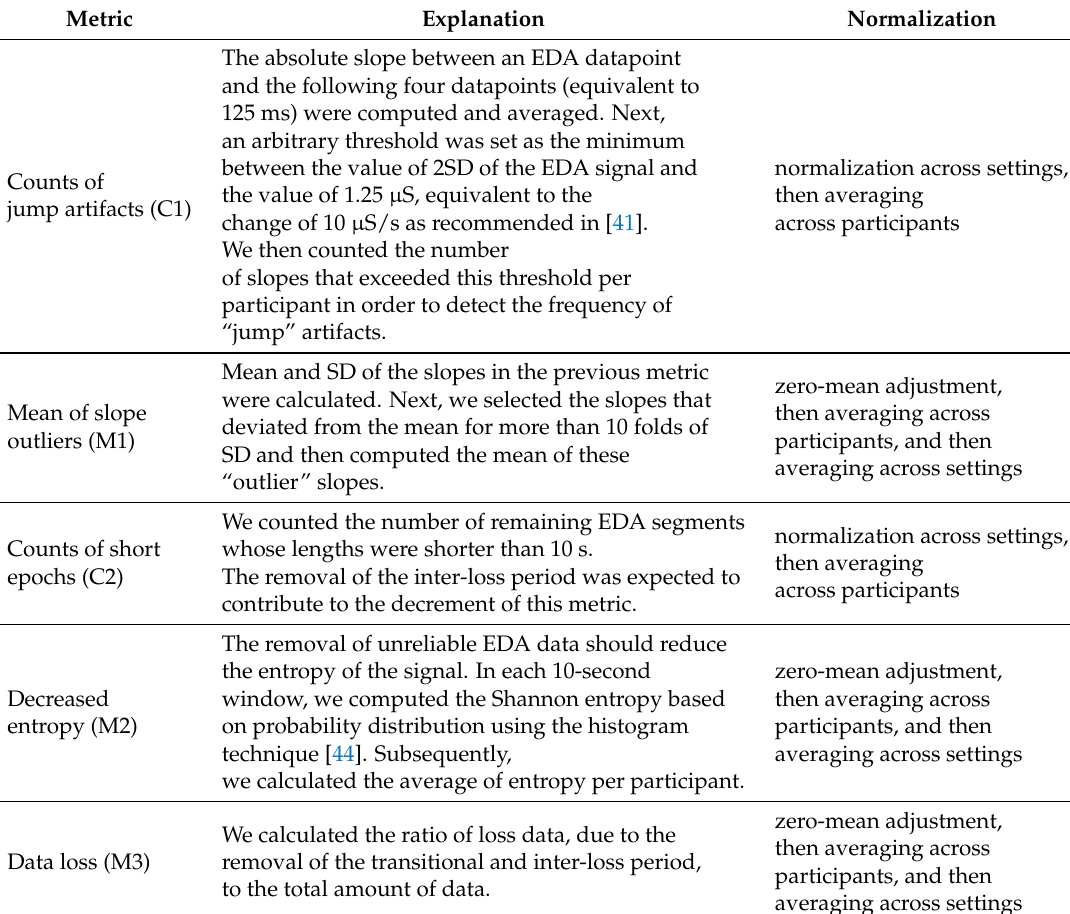
Table 1. Evaluation metrics for EDA removal